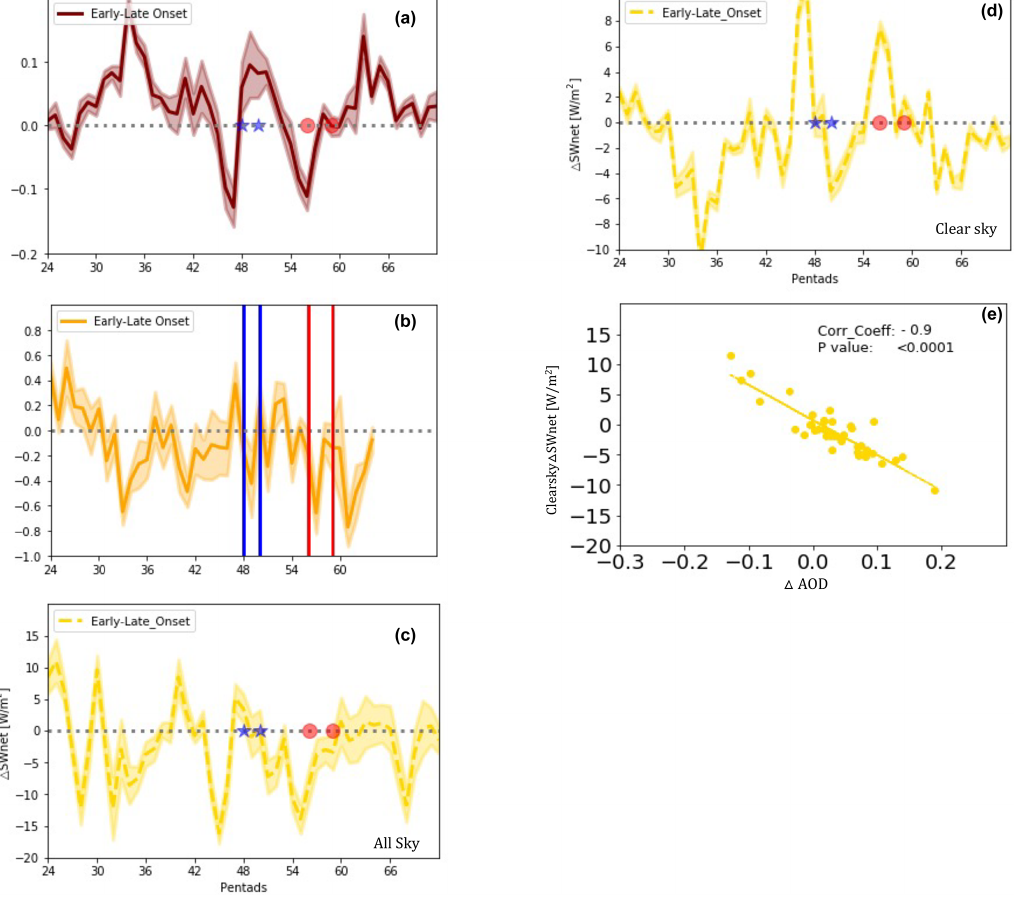
Figure 4. (a) Differences in MODIS AOD ( δ AOD) from the 24th (day 120) pentad to the 72nd pentad (day 360). (b) As in (a) but for δT s from AIRS. Values up to the 66th pentad are shown due to data unavailability in some days after the 66th pentad. (c) As in (a) , showing the all-sky net downward shortwave energy difference at the surface ( δ SW net ) from CERES. (d) As in (a) but for clear-sky net downward shortwave energy difference at the surface ( δ SW net ) between the early- and late-onset years from CERES. (e) Correlation between δ AOD difference (in Fig. 3a) and clear-sky δ SW net (in Fig. 3d) between the early- and late-onset years at the surface. The shading shows two sigma errors.